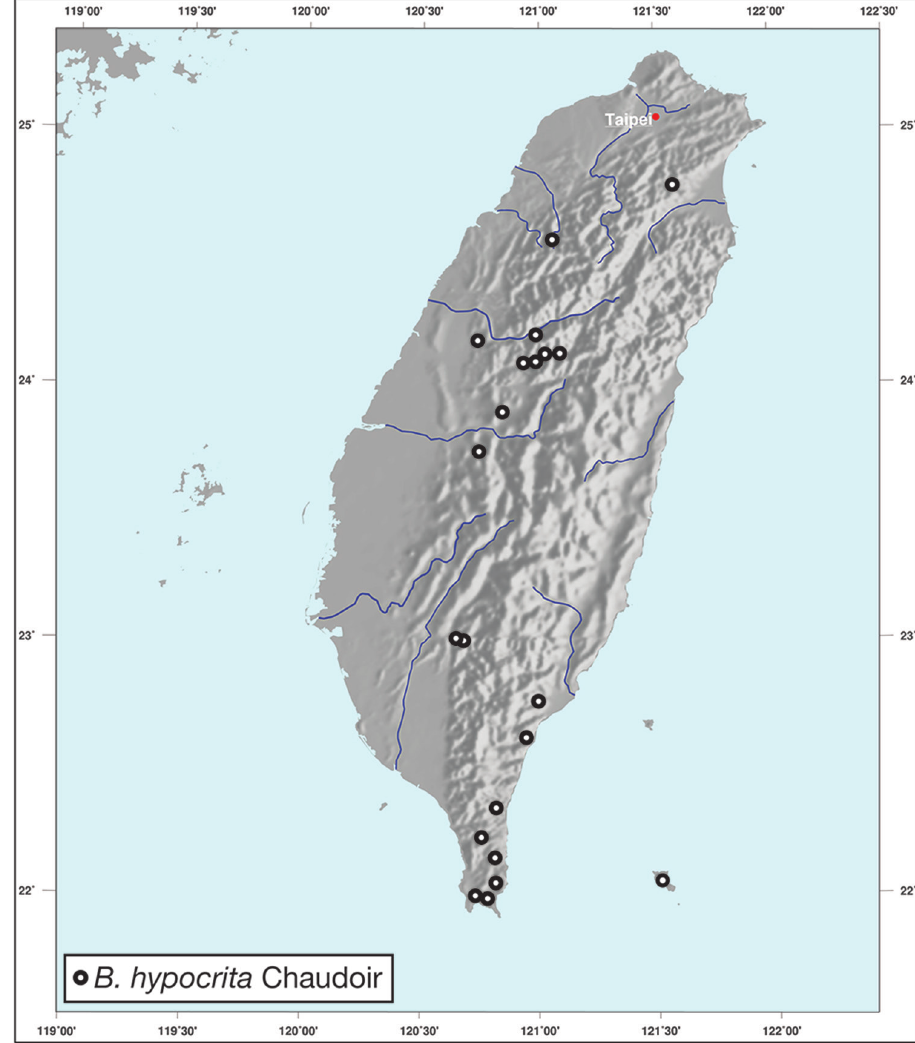
Figure 20. Map showing known localities for species of the genus Brachichila Chaudoir, in